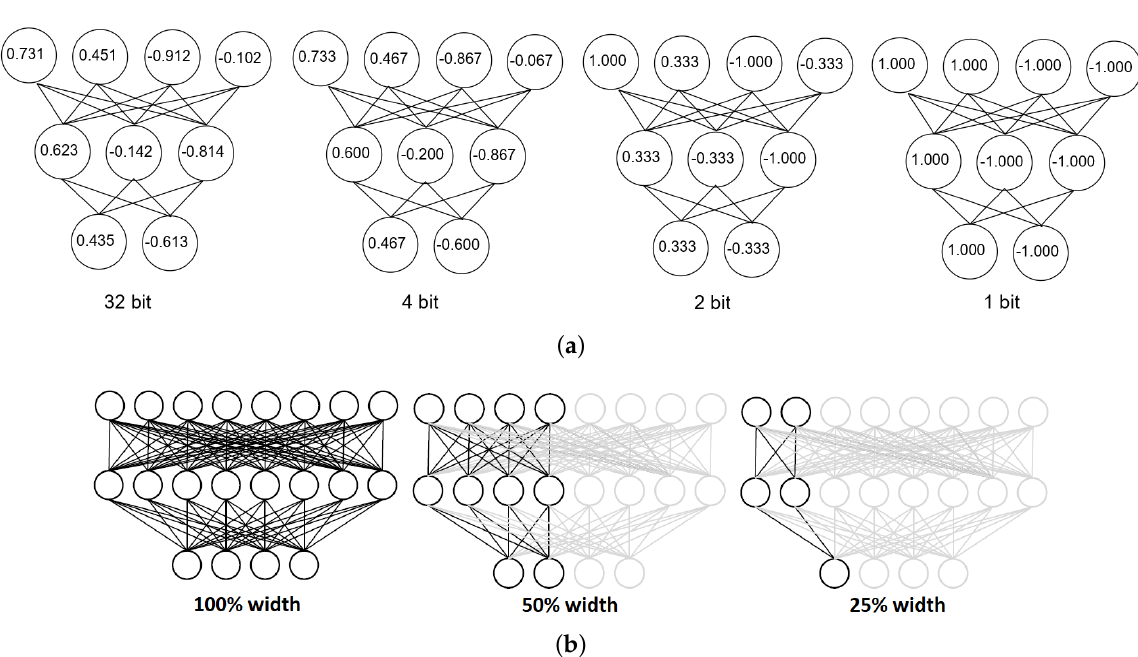
Figure 1. Illustration of the two neural network compression techniques used in our experiments. ( a ) Any-Precision Deep Neural Networks. ( b ) Slimmable Neural